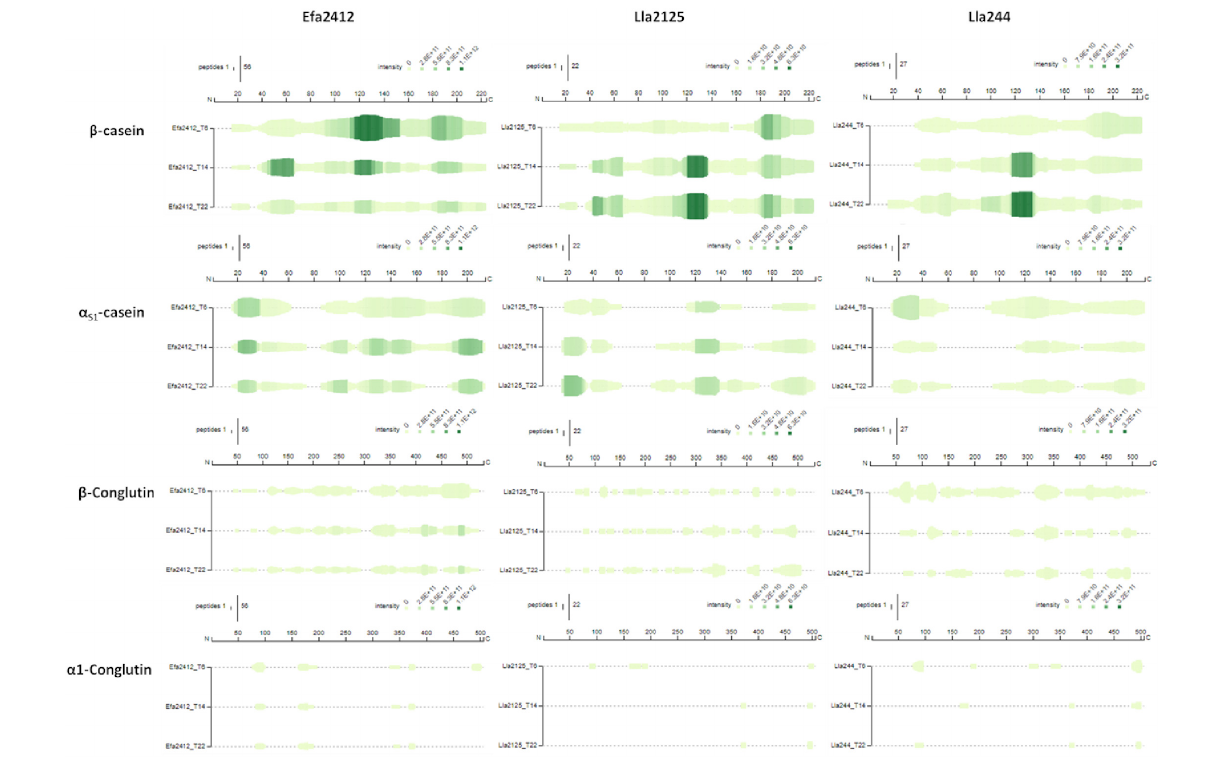
( Figure 6 ; Ji et al., 2021). The peptides early and